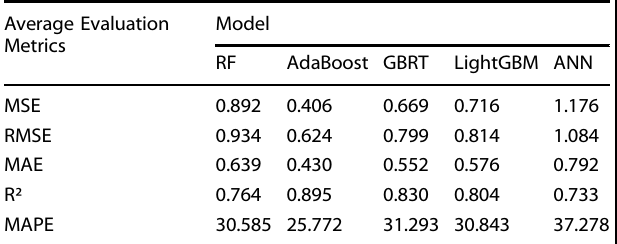
Table 3. Average performance of